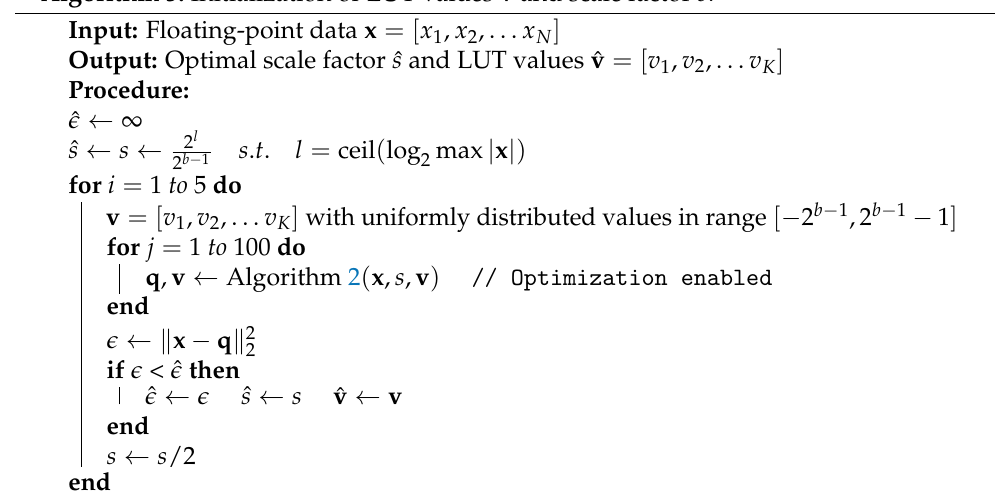
Algorithm 3: Initialization of LUT values v and scale factor s